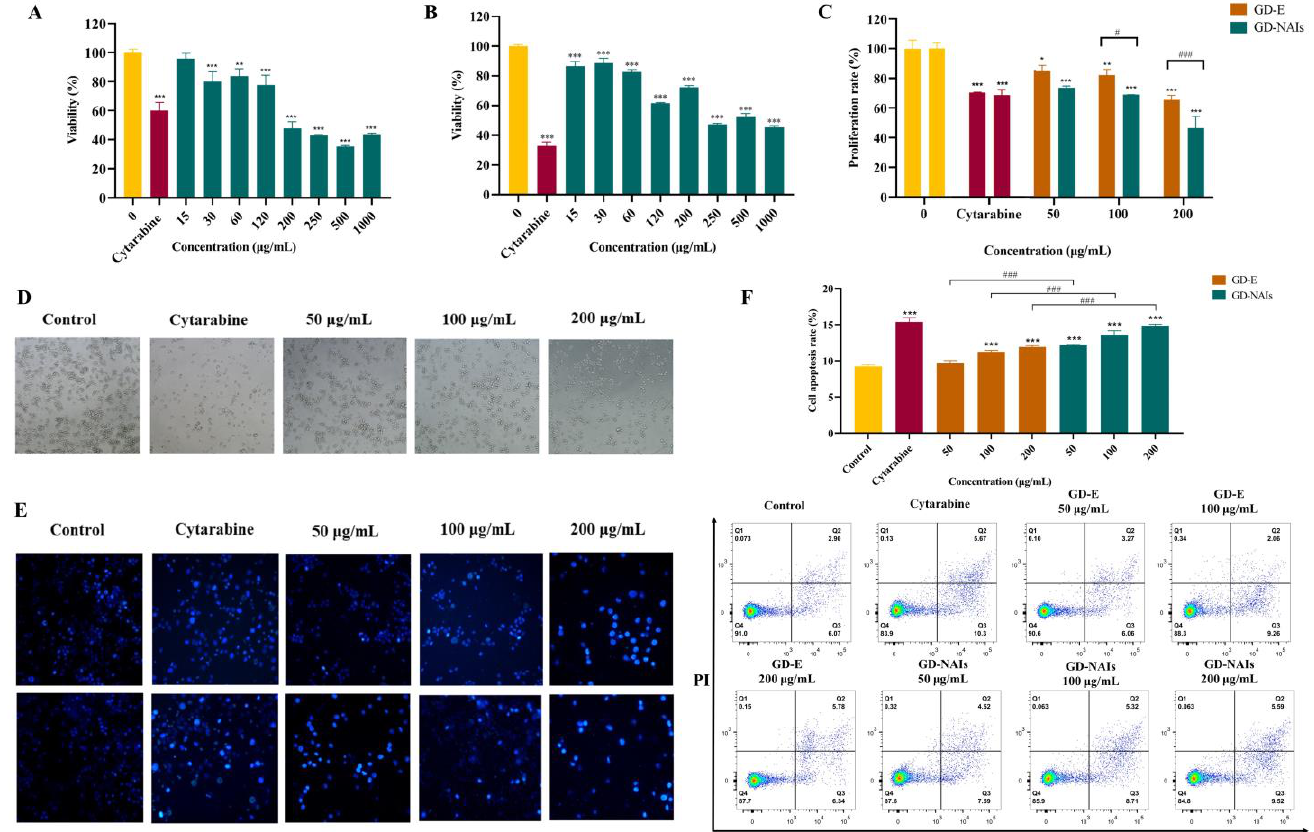
Figure 3. GD-NAIs suppress proliferation and induce apoptosis of K562 cells. ( A ) The viability of K562 cells was tested using a CCK-8 assay after treatment with cytarabine (20 nM) or GD-NAIs (15, 30, 60, 120, 250, 500 and 1000 μg/mL) for 48 h. ( B ) The viability of HEL cells was tested by CCK-8 assay after treatment with cytarabine (20 nM) or GD-NAIs (15, 30, 60, 120, 250, 500 and 1000 μg/mL) for 48 h. ( C ) The proliferation rate of K562 cells after treatment with cytarabine (20 nM) or GD-NAIs (50, 100 and 200 μg/mL) or GD-E (50, 100 and 200 μg/mL) for 48 h. ( D ) The cell morphology of K562 cells after treatment with cytarabine (20 nM) or GD-NAIs (50, 100 and 200 μg/mL) for 24 h. ( E ) Cell apoptosis was determined by Hoechst 33258 assay after treatment with cytarabine (20 nM) or GD-NAIs (50, 100 and 200 μg/mL) for 24 and 48 h. ( F ) Apoptosis was detected by flow cytometry after treatment with GD-NAIs (50, 100 and 200 μg/mL) or GD-E (50, 100 and 200 μg/mL) for 48 h, n = 3. * p < 0.05, ** p < 0.01, *** p < 0.001 compared to the control group. # p < 0.05, ### p < 0.001 compared between two groups.